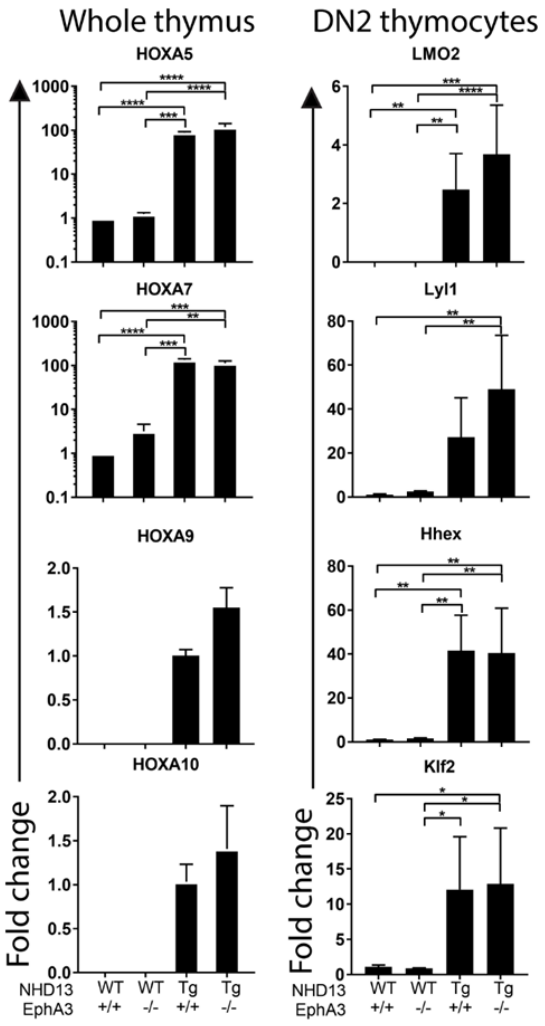
Figure 4. NHD13 abnormal self-renewal gene expression is unaffected by EphA3 deletion. RT-PCR testing was performed using 6-week-old whole thymus (left column) or FACS-sorted DN2 (DN2A and DN2B, CD44 + , CD25 + right column) thymocyte samples for each indicated genotype. The average fold change expression of HoxA5, HoxA7, HoxA9, HoxA10 , LMO2, Lyl1, Hhex , and Klf2 genes was as indicated. Bars represent the mean ± S.E.M of three mice per group. p -values were calculated using Student’s t -test (* p < 0.05, ** p < 0.005, *** p < 0.0005, **** p <